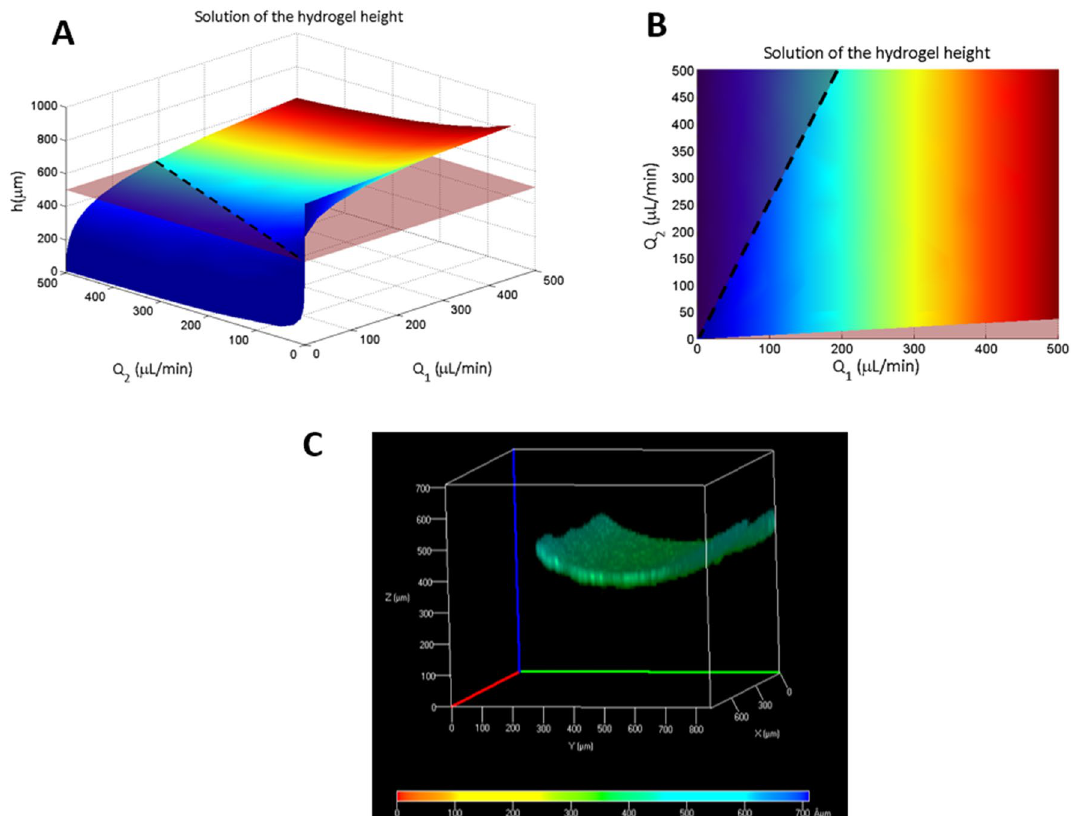
Figure 7. ( A ) Surface of flows (Q 1 for the sacrificial fluid and Q 2 for the pre-gel) as a function of the height predicted by the parallel flow mathematical model. The plane z = 500 µm plotted in pink corresponds to the height chosen for the dermal compartment (hydrogel). The intersection line between the surface of solutions and z = 500 µm is depicted as a dashed black line. ( B ) Top view of the solution in ( A ) showing the dashed black line of possible flows (Q 1 and Q 2 ) to obtain a dermal compartment 500 µm high. ( C ) Confocal image of the gel. The Y axis correspond to the width of the chamber and the X axis correspond to the length of the chamber. The Z axis represents the height of the chamber. z = 0 corresponds to the position of the porous membrane. The figure represents a field of view of 800 µm × 800 µm in the XY plane at the centre of the UC. The colour code at the bottom of the figure indicates the height at which the seeded fluorescent hKCs are found (the hydrogel’s